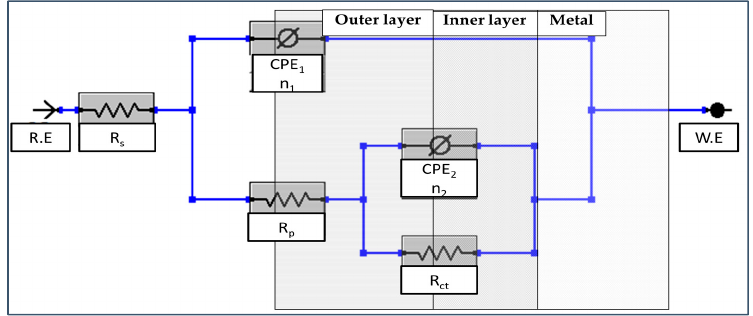
Figure 3. Electrical equivalent circuit used to analyze the present experimental EIS (electrochemical impedance spectroscopy) data .